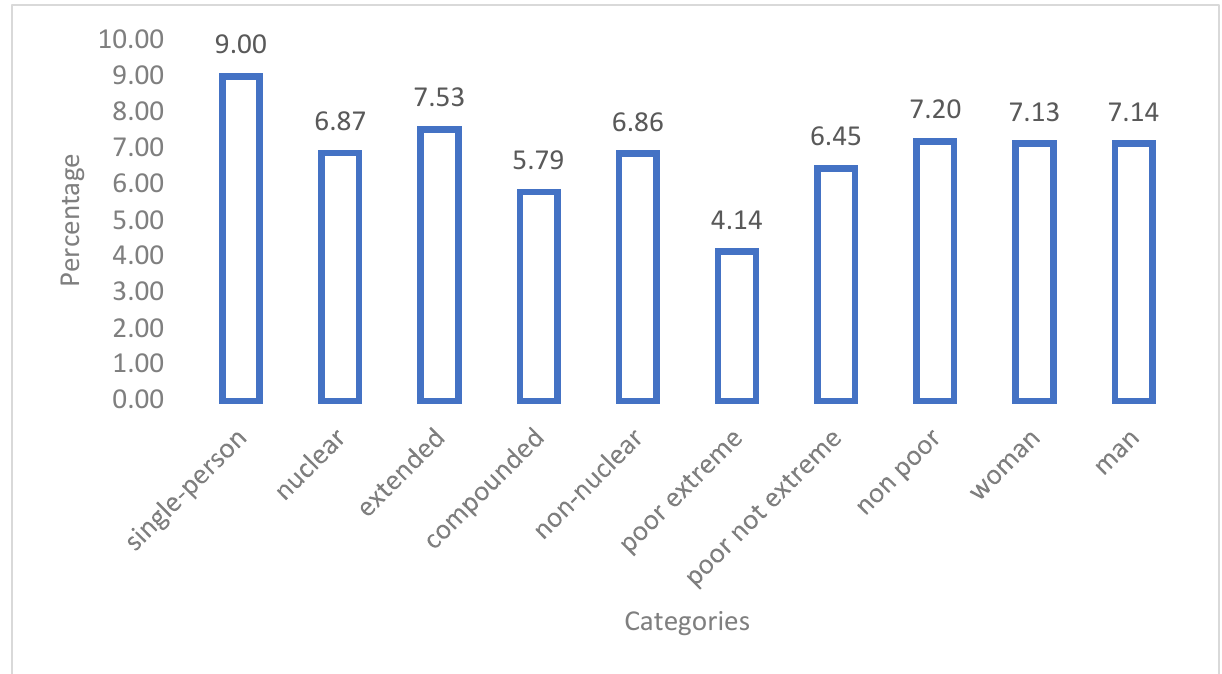
Figure 1. Food expenditure outside the household as percentage with respect to total net income (in PEN).